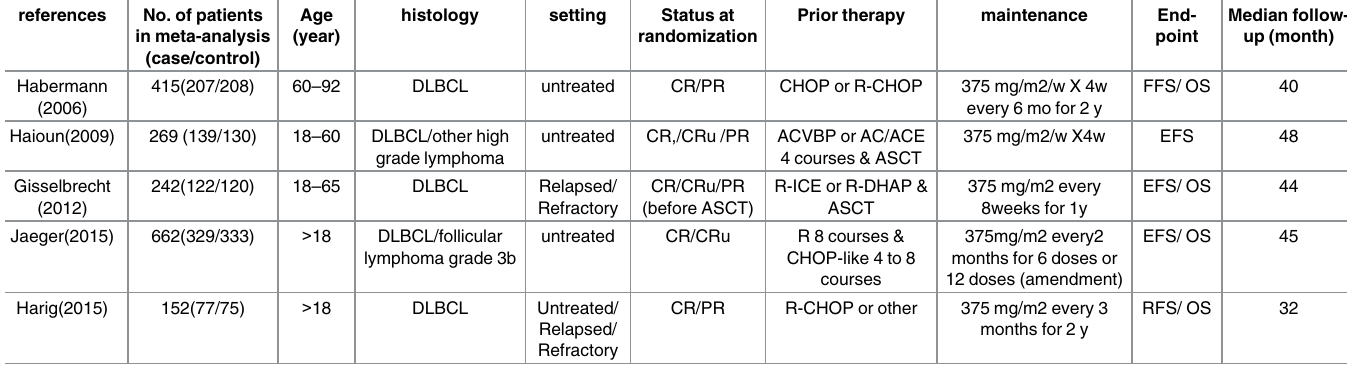
Table 1. Characteristics of included